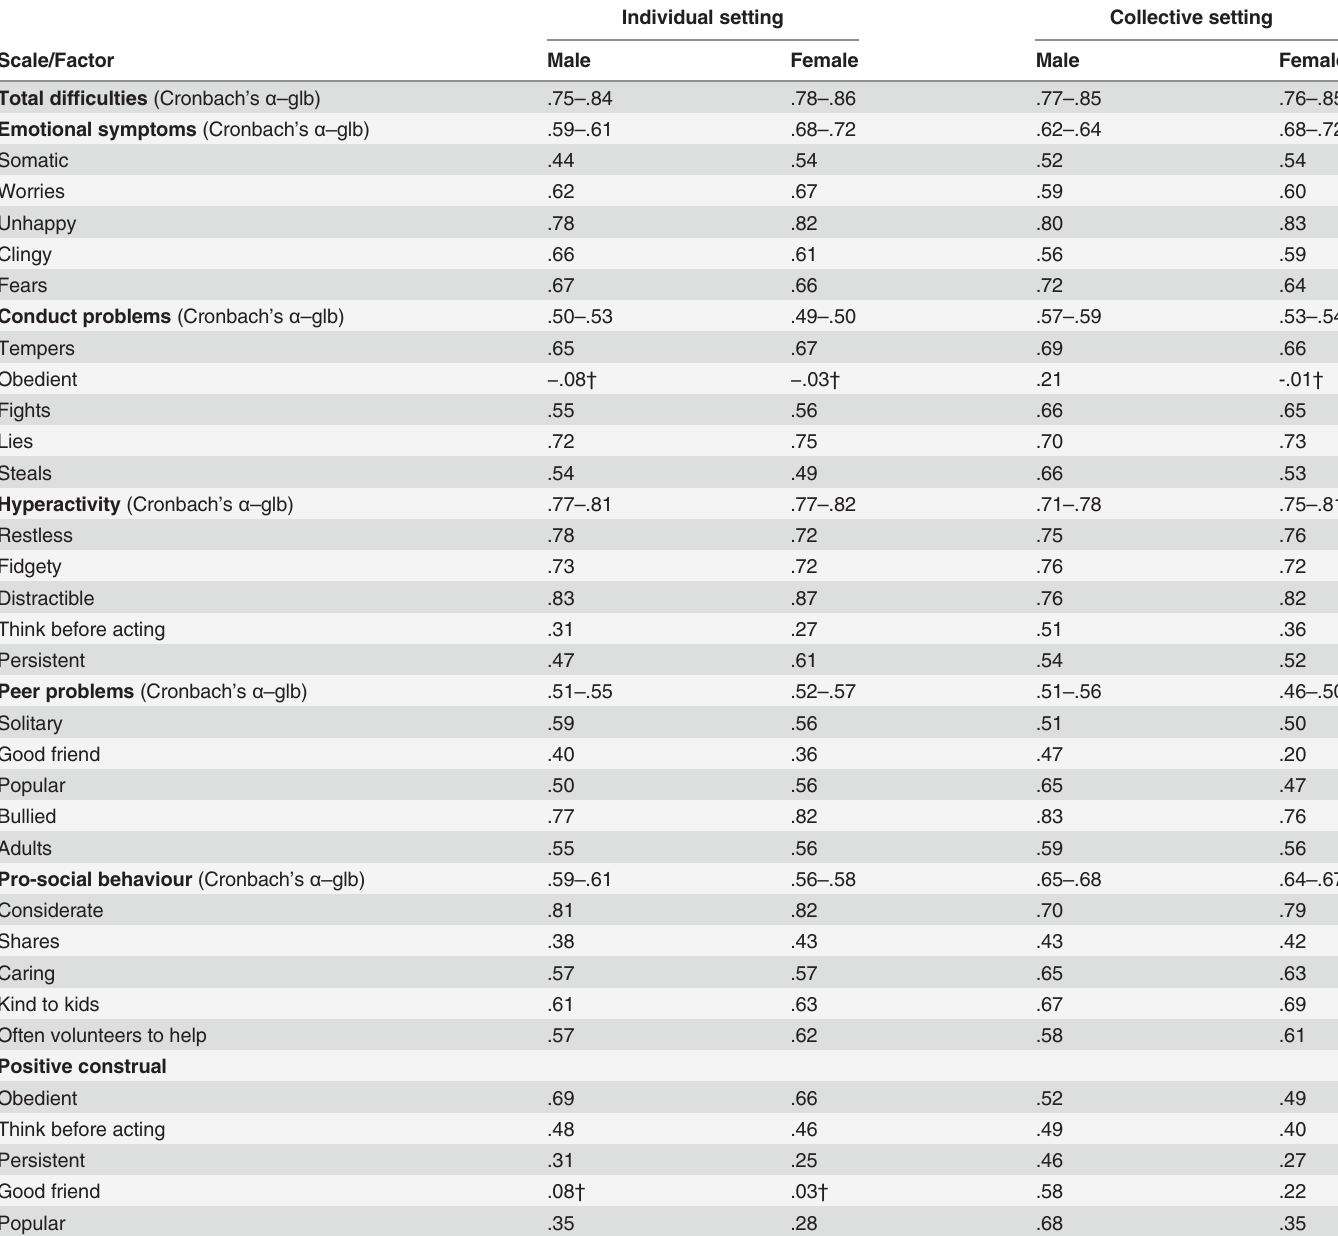
Table 2. Internal consistency of the SDQ scales and standardized factor loadings of the CFA for the 5-factor model with positive construal factor for each setting and gender